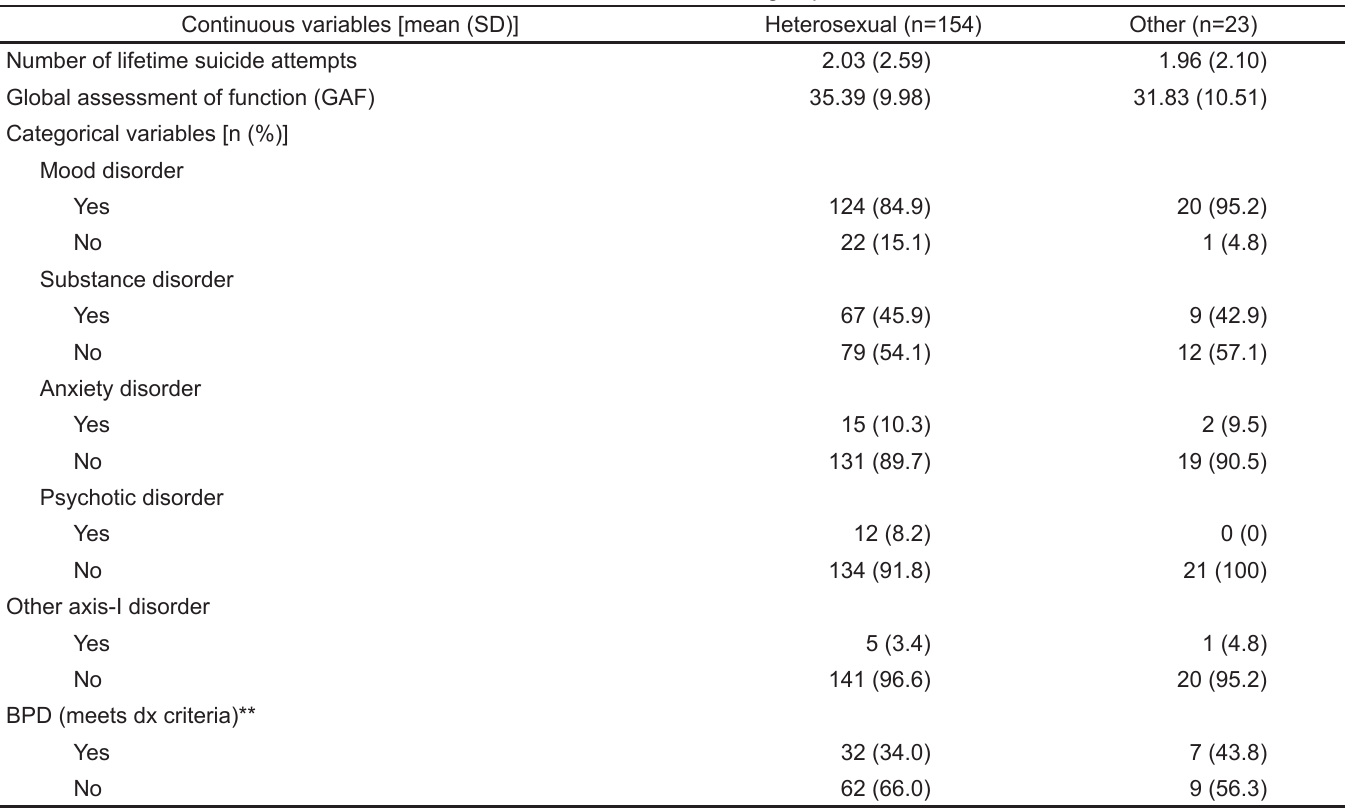
Table 2. Clinical characteristics for heterosexual and other than heterosexual groups.*